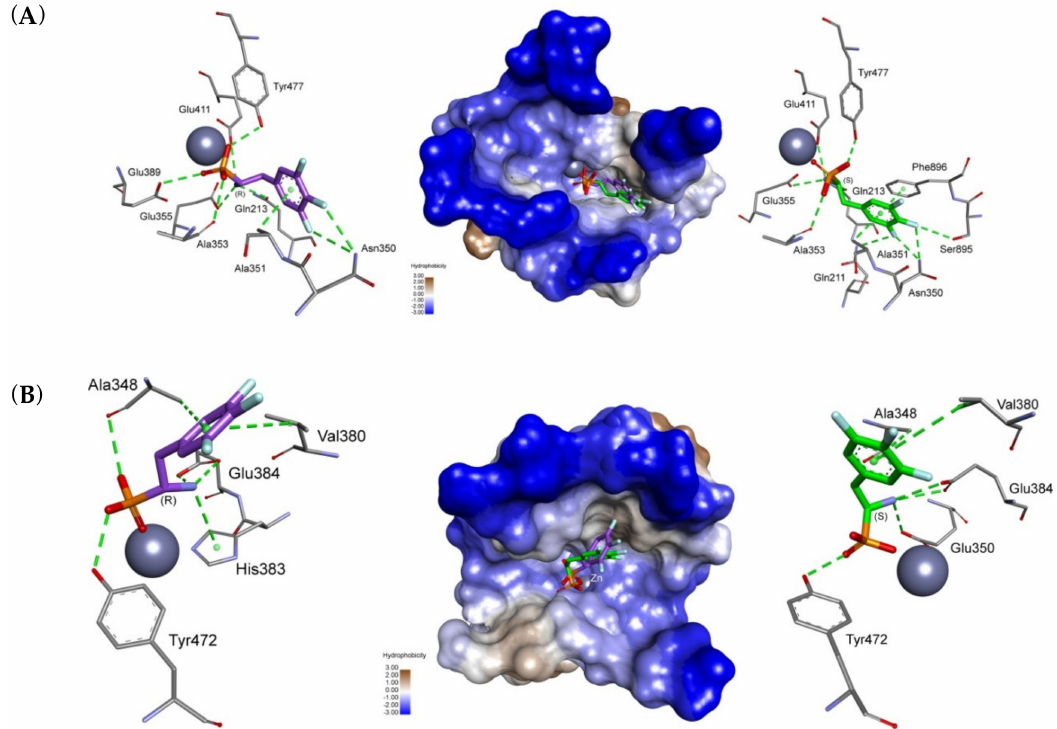
Figure 3. Modes of binding of both enantiomers of 1-amino-2-(3,4,5-trifluorophenyl)ethylphosphonic acid (compound 1l ) to hAPN ( A ) and pAPN ( B ). Right hand side—R-isomer; left hand side—S-isomer. Coloration of the oxygen, amino and fluorine atoms is identical to that in Figure